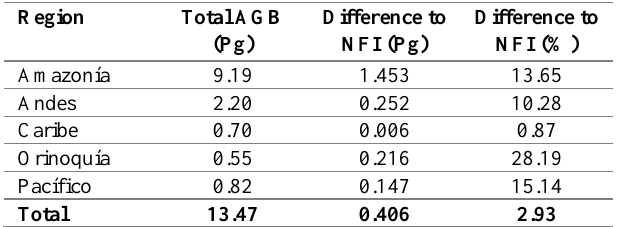
Table 1. Comparison between AGB map estimates and